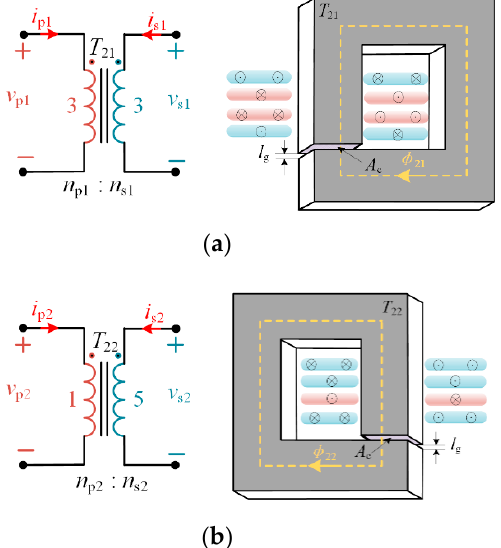
Figure 2. Transformer T 2 with the uneven winding distribution. ( a ) Winding connection and UI (U-type and I-type) core structure of T 21 , ( b ) winding connection and UI core structure of T 22 .